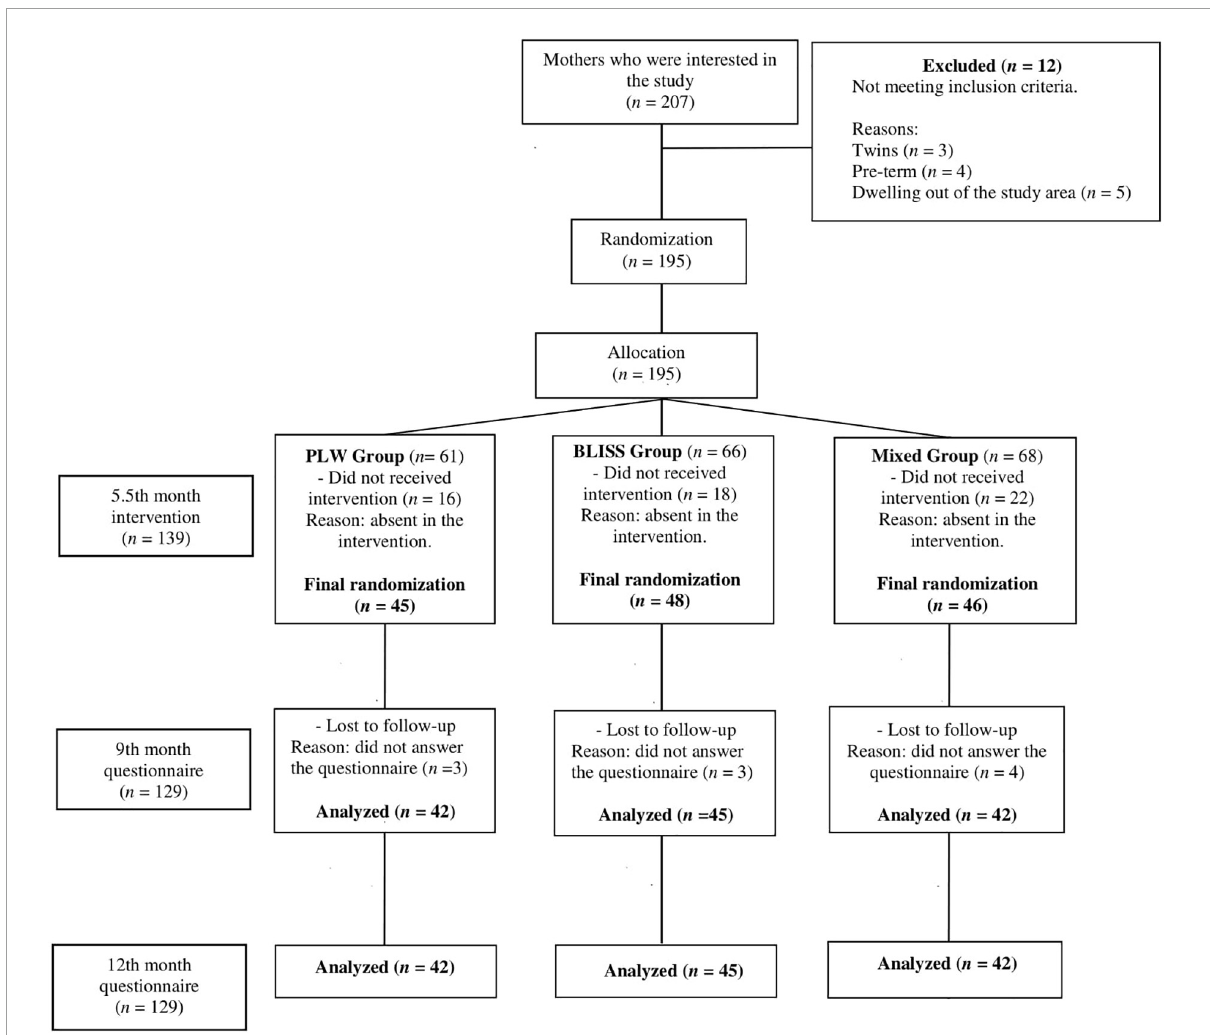
FIGURE1 Study design flow chart, Brazil, 2019–2021. PLW, parent-led weaning; BLISS, baby-led introduction to